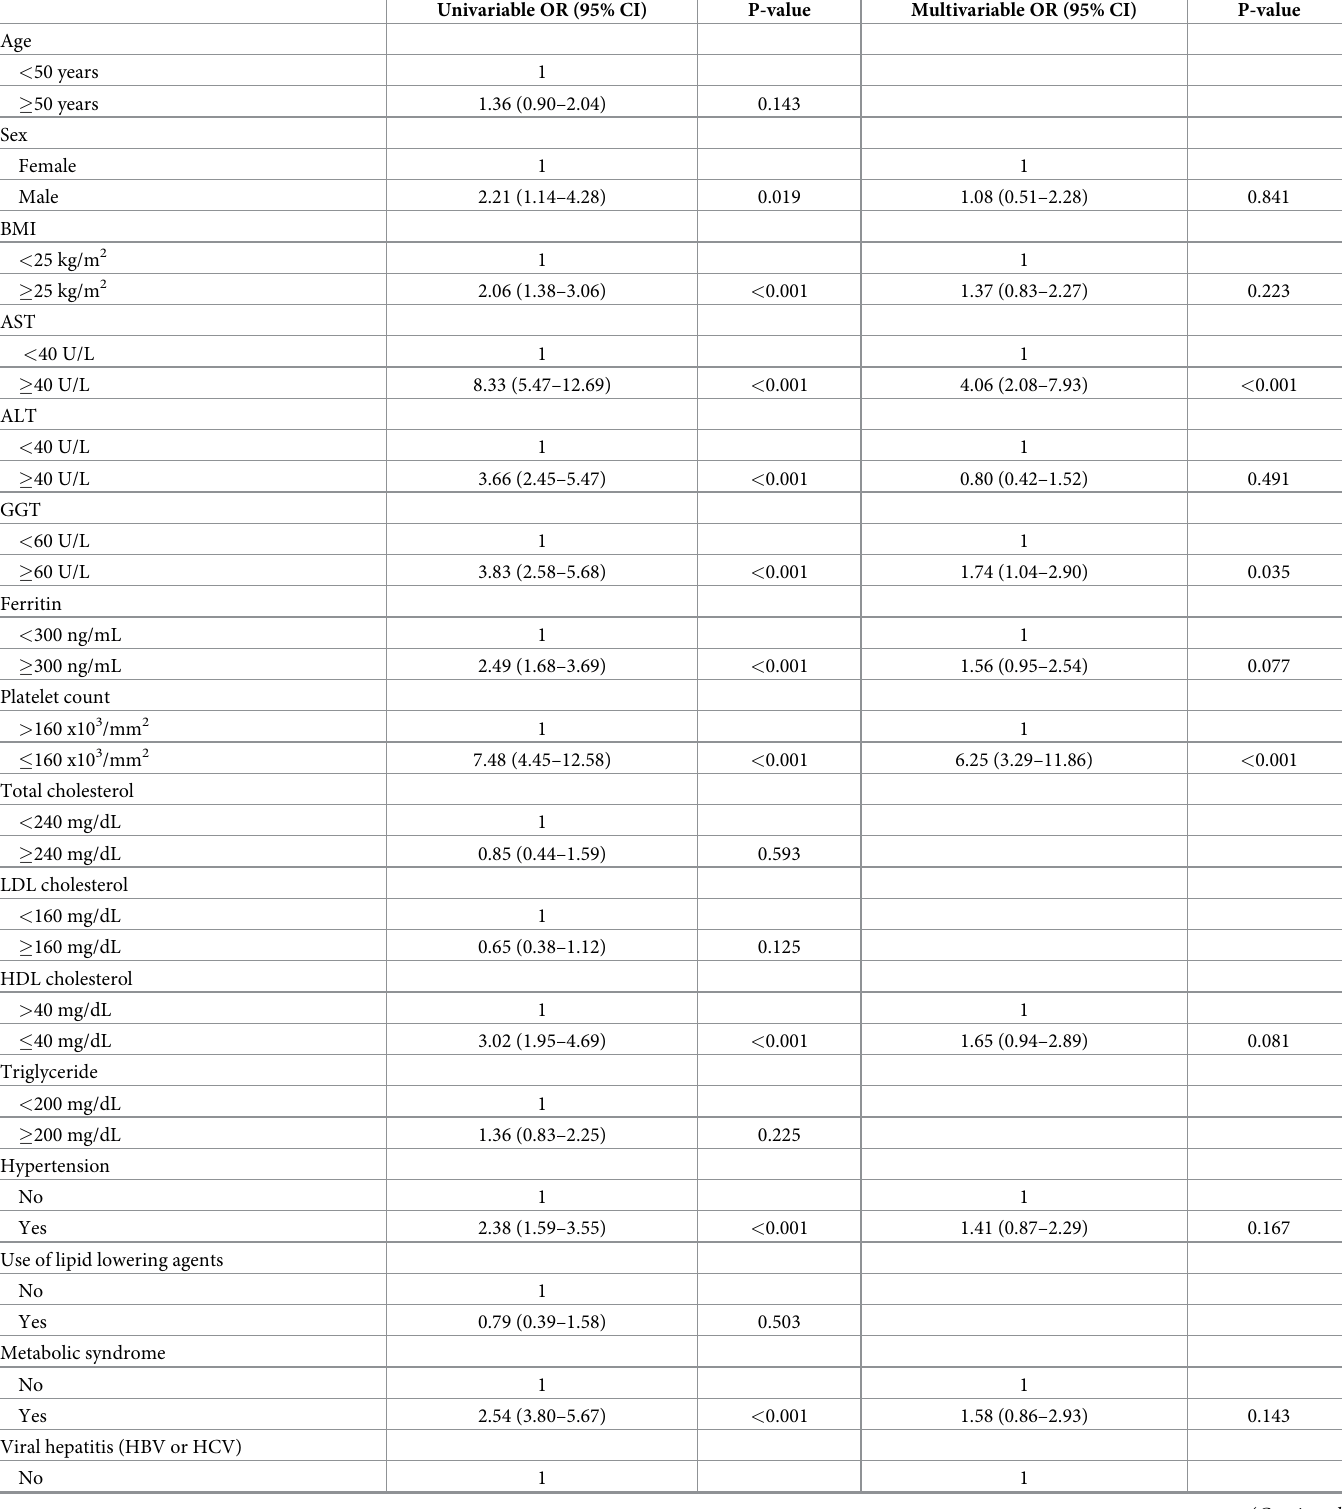
Table 3. Risk factors for significant fibrosis ( � 2.97 kPa of LSM in